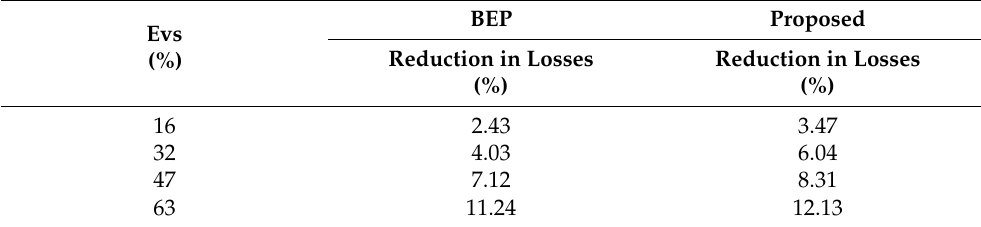
Table 2. A comprehensive comparison of results of all the three